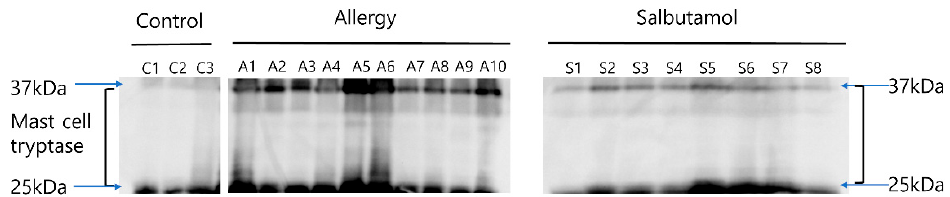
Figure 5. Representative western blot analysis of tryptase levels in murine intestinal mucosa. Bands were cropped from different parts of the same gel or from different gels. Three mice in the control group, ten mice in the AAD group, and eight mice in the salbutamol group were compared and analyzed.